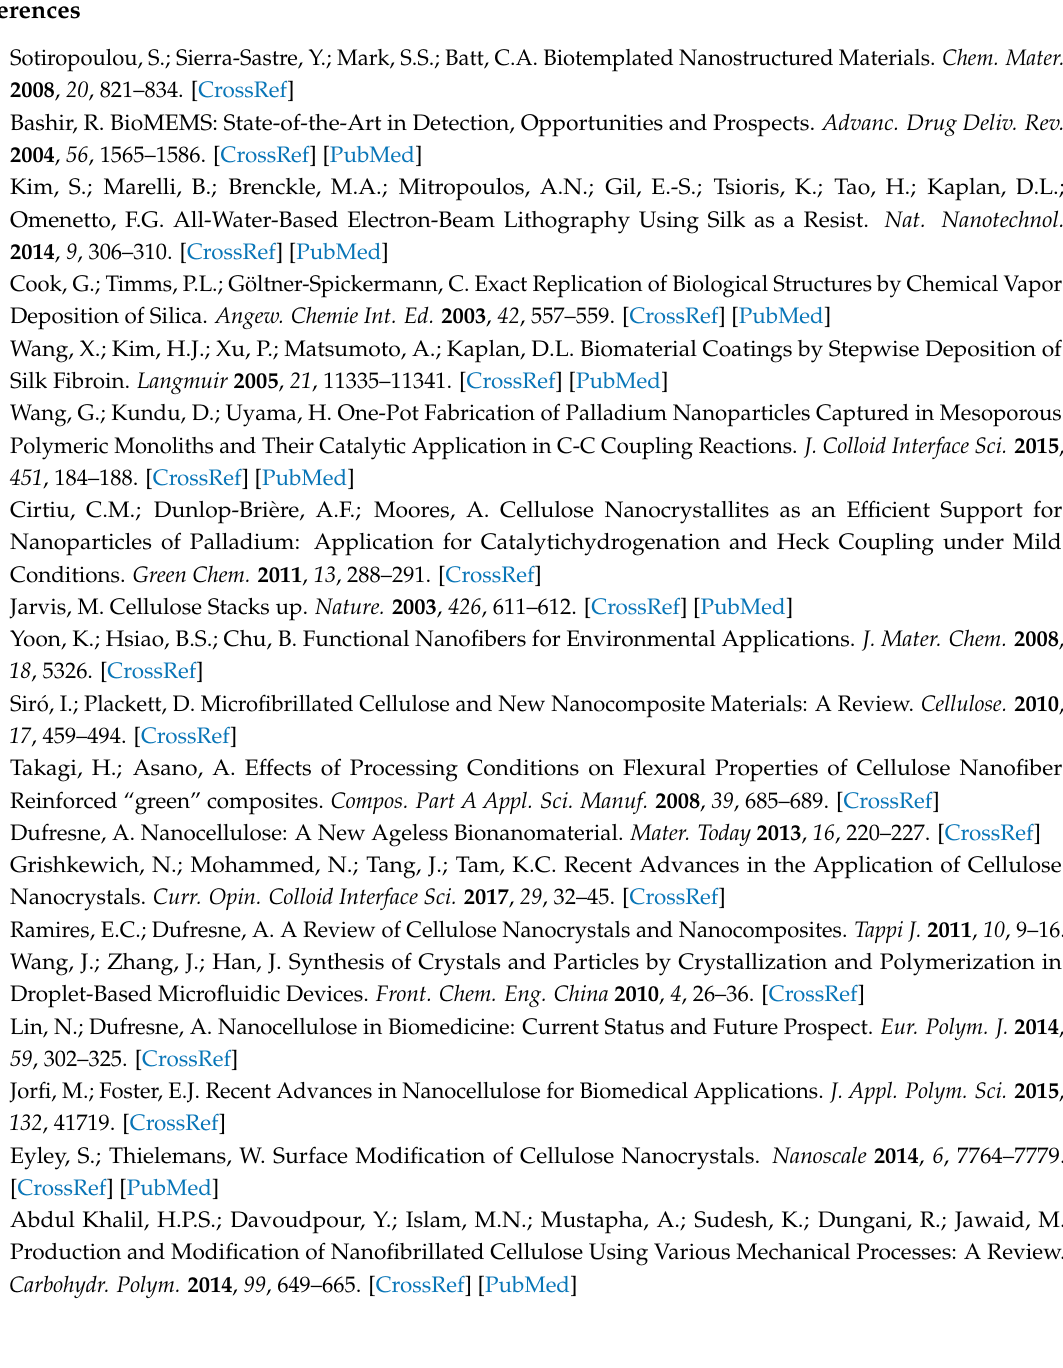
Figure S3: TGA of aerogels synthesized with Na 2 PdCl 4 , Figure S4: Nitrogen gas adsorption–desorption overlay, and Figure S5: EIS